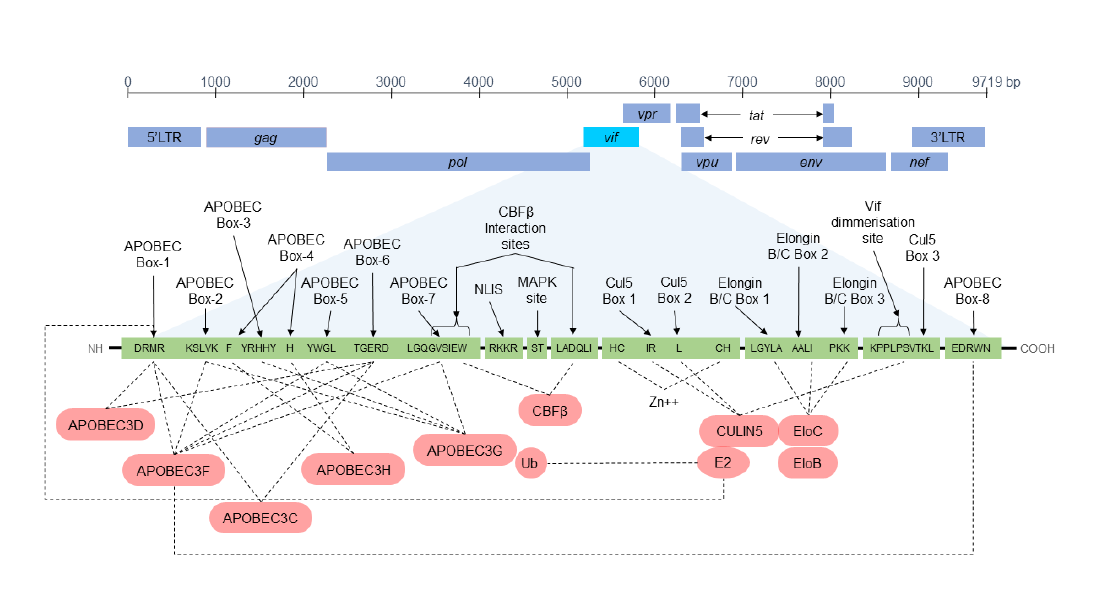
Figure 7. Position of the Vif encoding region within a reference (HXB2) HIV-1